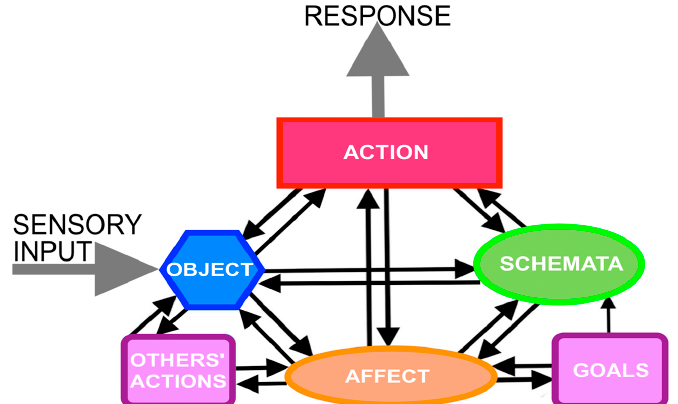
Figure 2. The six modules of Action Cycle Theory: Object, Schemata, Action, Affect, Goals and Other’s Actions . The large grey arrows represent sensory input and the organism’s response in perception. In mental imagery, the system of six modules is activated in the absence of sensory input. The black arrows indicate hypothesized causal relationships. The majority of interconnections are reciprocal, meaning that any module can causally influence, and be causally influenced by, its neighbors. The absence of an arrow going from Schemata to Goals indicates that Schemata do not influence Goals that are determined only by Affect, i.e., the degree to which happiness or pleasure can be increased and/or pain can be diminished. In ACT, the perceptual system involves an exploratory cycle that harmonizes inter- actions with objects motivated by the drive to maximize equilibrium and positive affect.